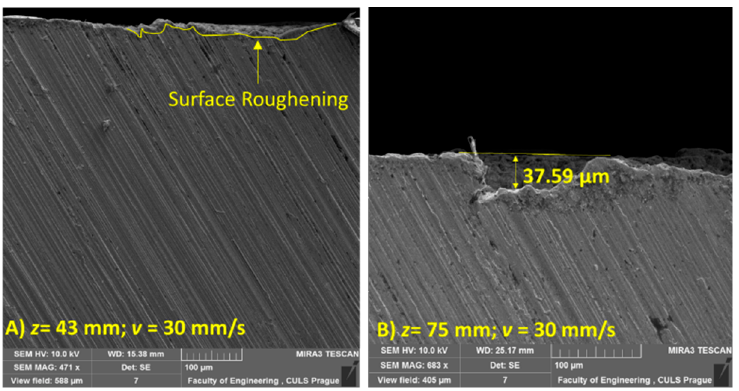
Figure 10. Cross-sectional SEM image of sample subjected to p = 70 MPa, v = 30 mm/s, and ( A ) z = 43 mm or ( B ) z = 75 mm.